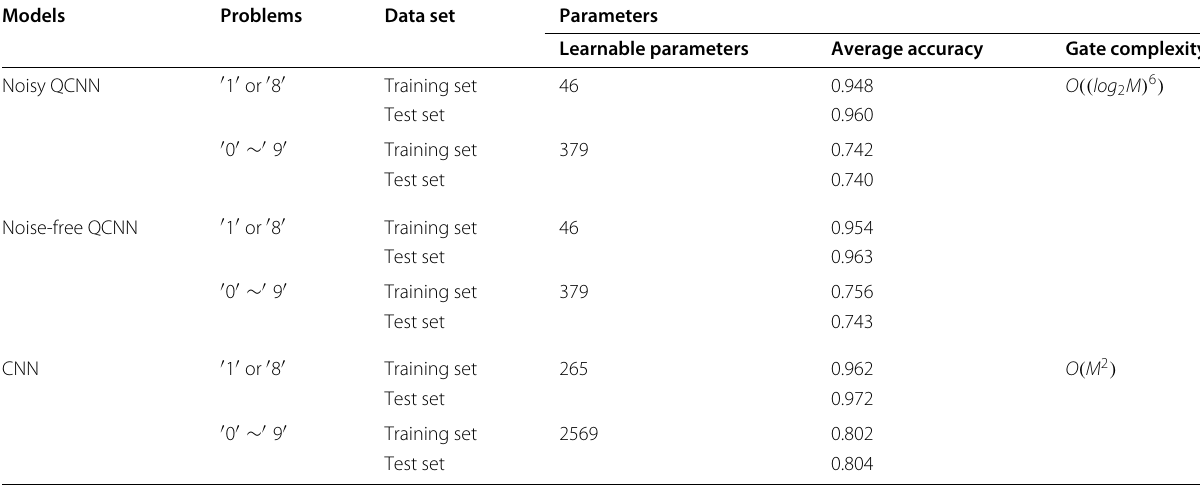
Table 1 The important parameters of models